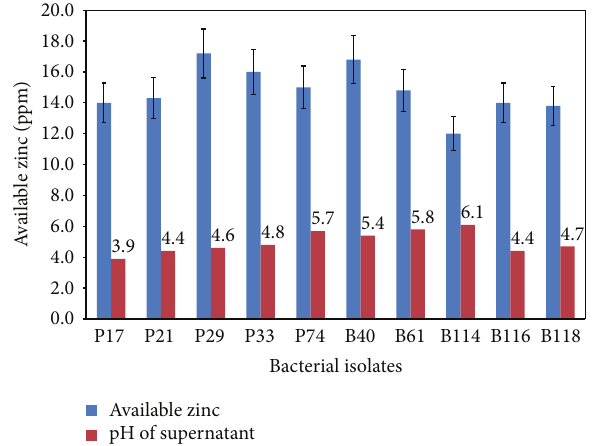
Figure 2: Available zinc (mg ⋅ kg −1 ) released by bacteria in broth medium containing zinc